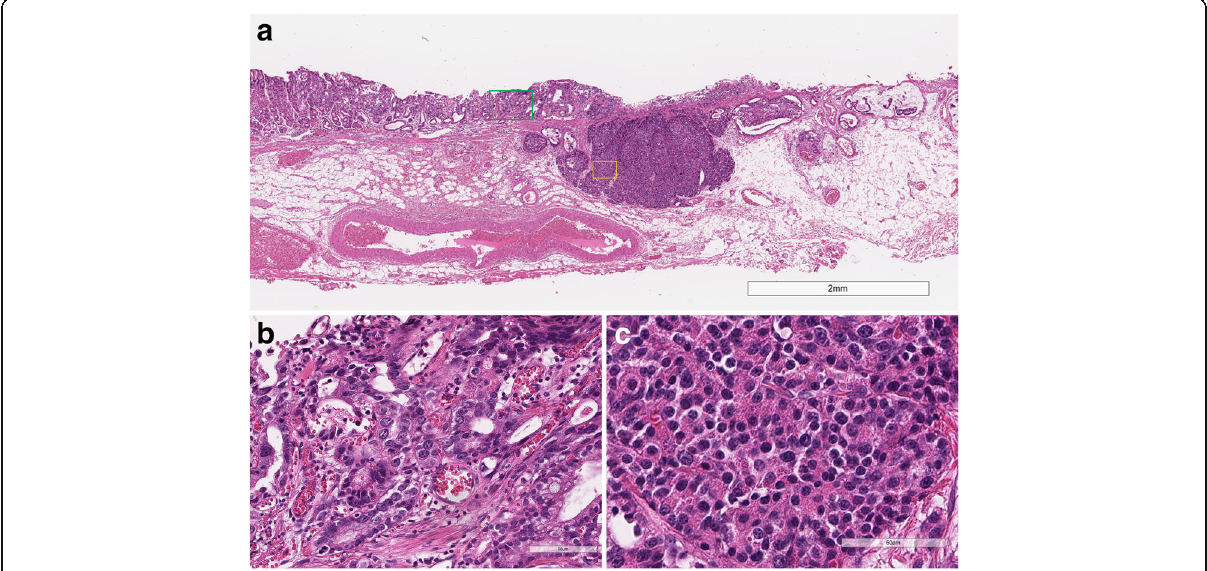
Fig. 1 Histology of the tumor (hematoxylin and eosin [H&E] stain). a Low magnification. The green square indicates the area shown in ( b ), the yellow square indicates the area shown in ( c ). b The glandular tumor component. c The solid tumor